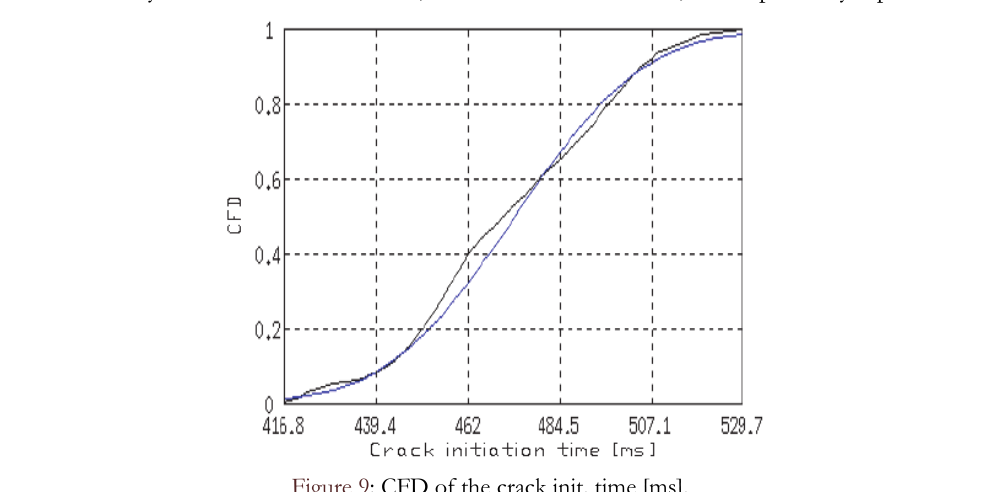
Figure 9: CFD of the crack init. time